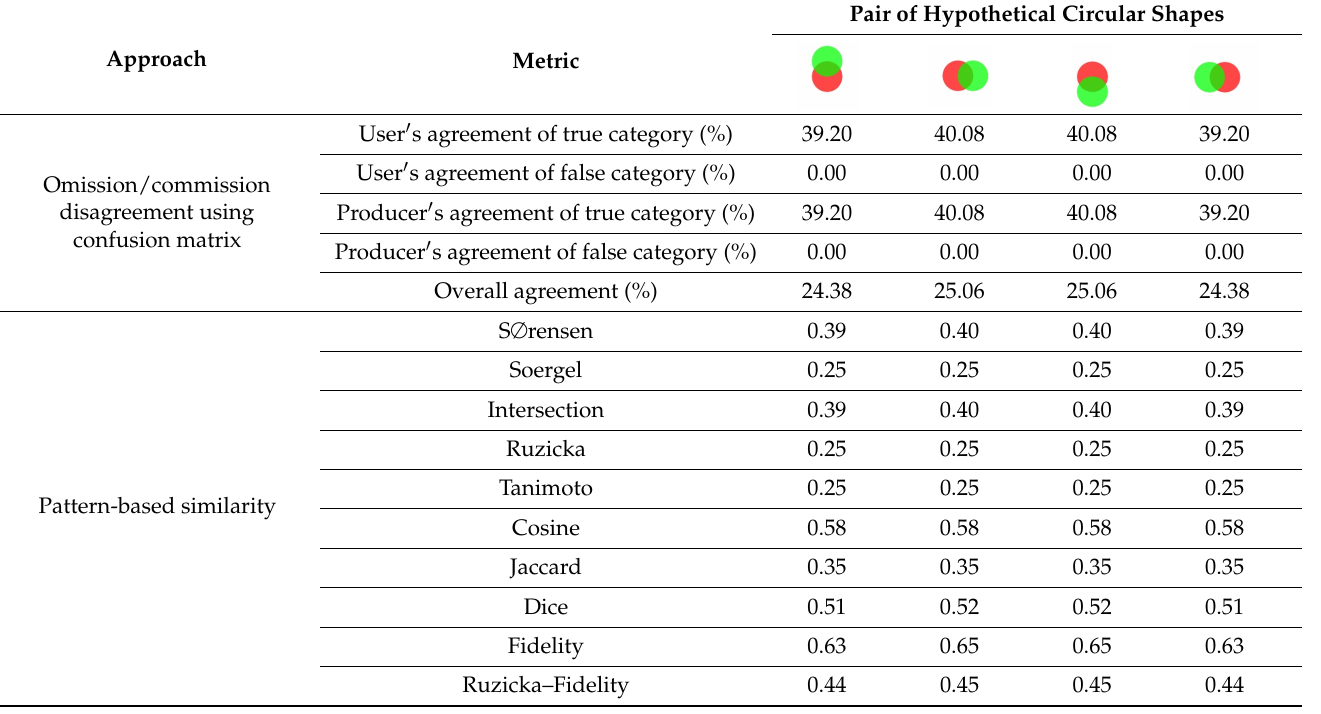
Table A2. Comparison between omission/commission disagreement approach and pattern-similarity based approach to measure pairs of a hypothetical circular shape and their displacements in cardinal directions intersecting each other. Pair of Hypothetical Circular Approach Metric